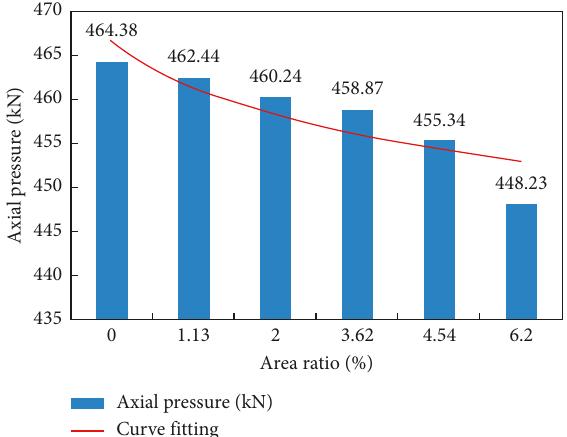
Figure 22: Relationship between the area ratio and axial pressure of